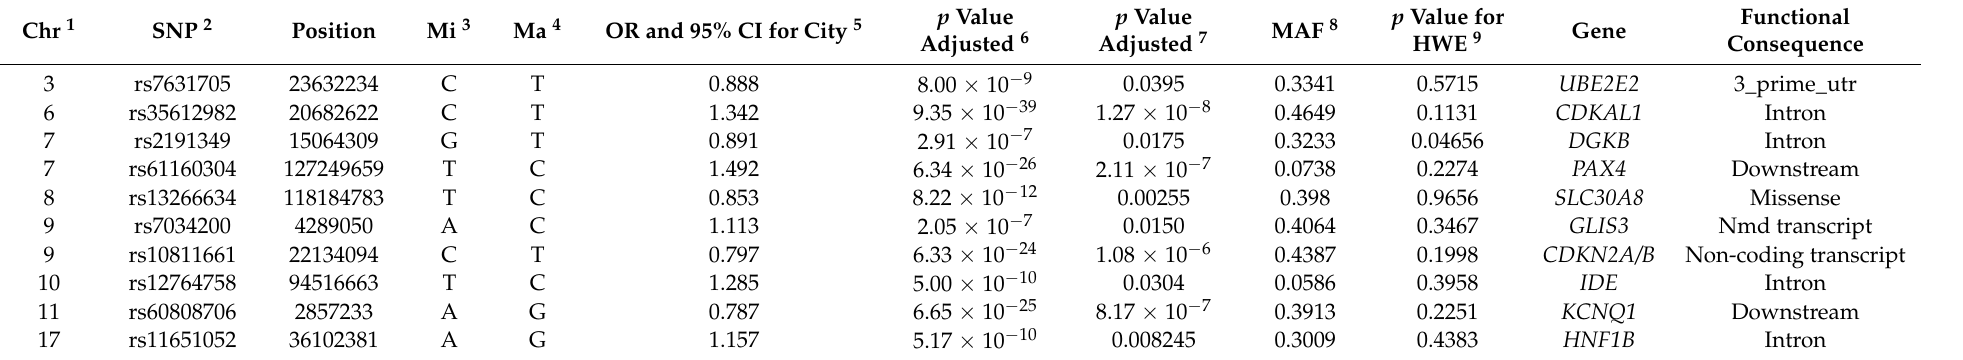
Table 3. Characteristics of genetic variants selected for their interactions by generalized multifactor dimensionality